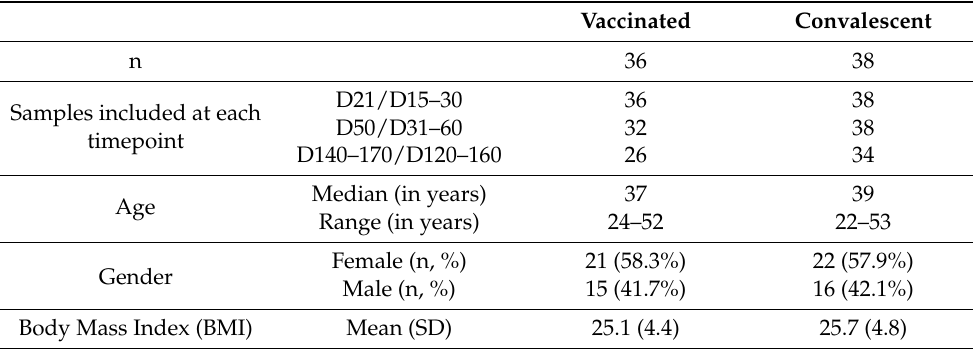
Table 1. The demographic characteristics of vaccinated and recovered individuals.